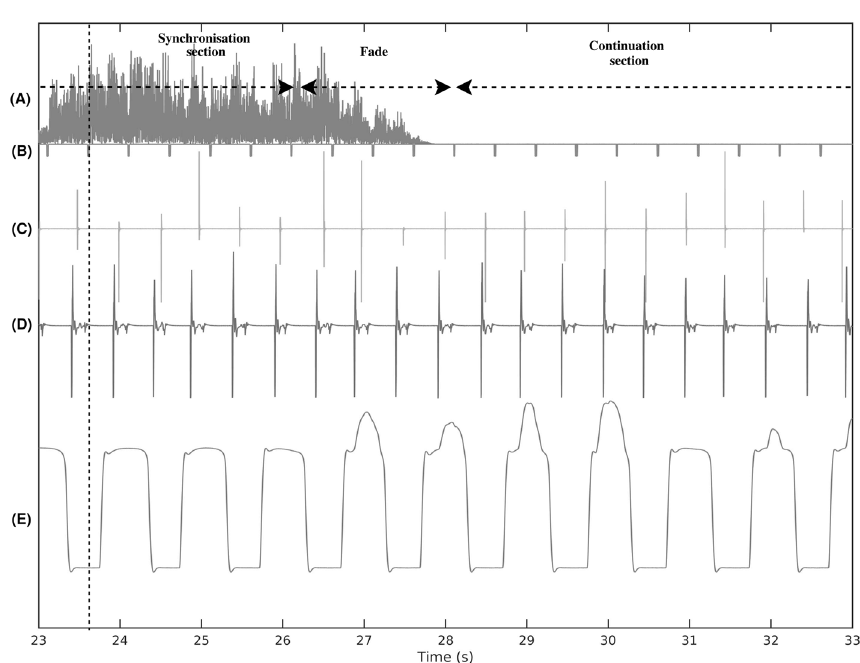
Figure 2. Example of a 10-s sample of the auditive stimuli, and the different measured variables: sound spectrum ( A ), beat position ( B ), finger tapping data ( C ), toe tapping data ( D ), and marching on the spot data (right foot; E